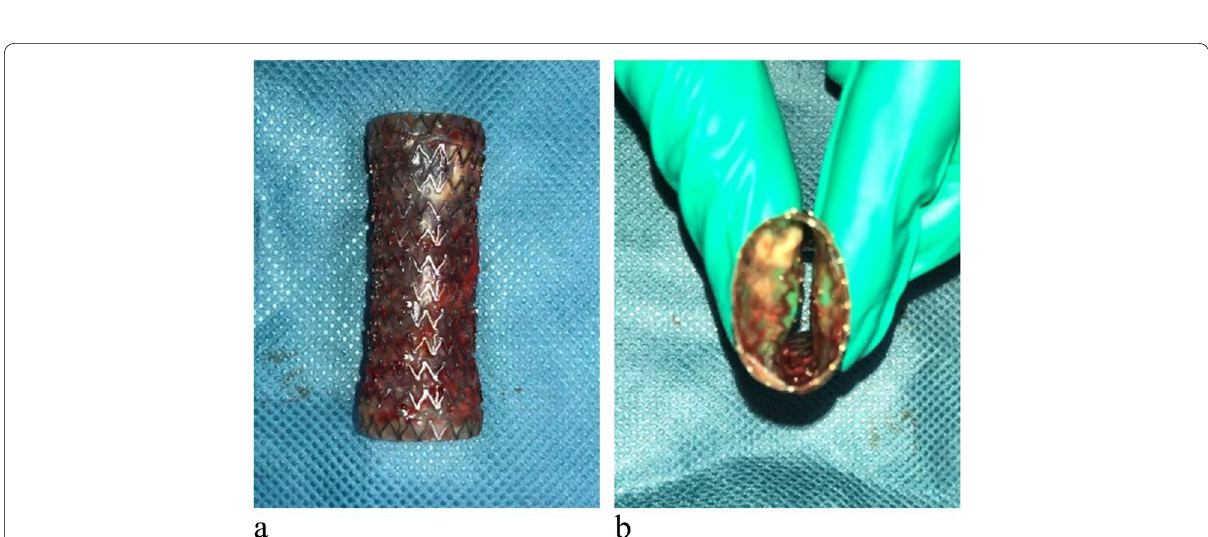
Fig. 2 Removal of the AERO TM stent in this case. a The AERO TM stent is a full-coverage stent in which the entire wall of the metal stent is covered with a polyurethane membrane. Because the entire metal part is covered by the membrane, it does not become implanted into the airway and is easy to remove and modify. b The inside of the stent has a hydrophilic coating, which reduces fluid retention and is flexible enough to be